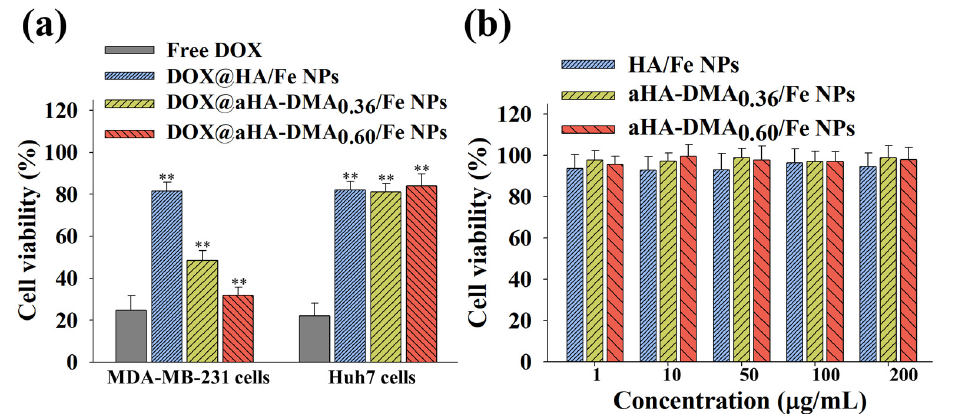
Figure 4. ( a ) Cell viability was determined by CCK-8 assay of MDA-MB-231 cells and Huh7 cells treated with free DOX (10 µ g/mL) or NPs (equivalent to DOX of 10 µ g/mL) for 24 h of incubation at 37 ◦ C ( n = 7, as multiple experiments, ** p < 0.01 compared to free DOX). ( b ) Cell viability was determined by CCK-8 assay of MDA-MB-231 cells treated with NPs (1–200 µ g/mL, without DOX) for 24 h ( n = 7, as multiple experiments).